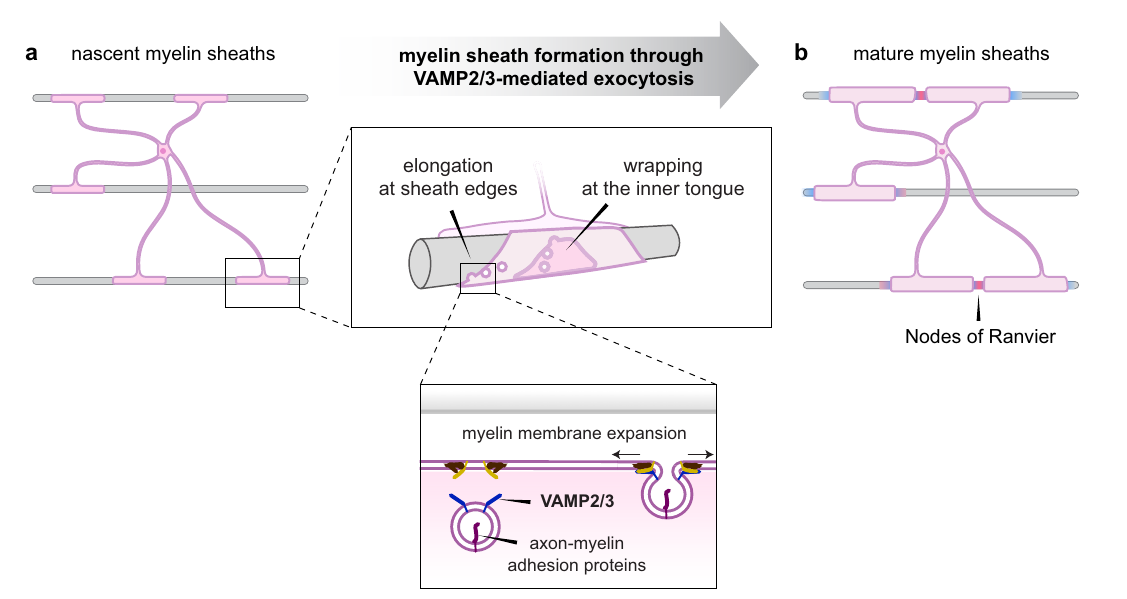
Fig. 7 | Model fi gure of how VAMP2/3-mediated exocytosis drives CNS myeli- nation. a In nascent myelin sheaths, VAMP2/3-mediated exocytosis occurs at the inner tongue to drive wrapping and atsheath edges to drive elongation. VAMP2/3- mediated exocytosis results in full-vesicle fusion that incorporates myelin